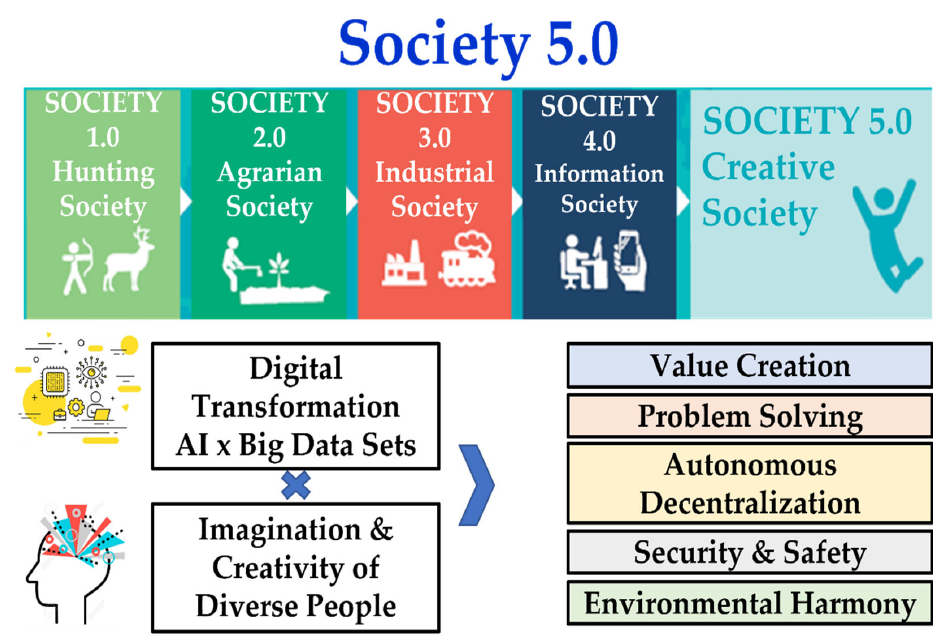
Figure 7. Evolution of society—Co ‐ creating the future (adapted from [35]).